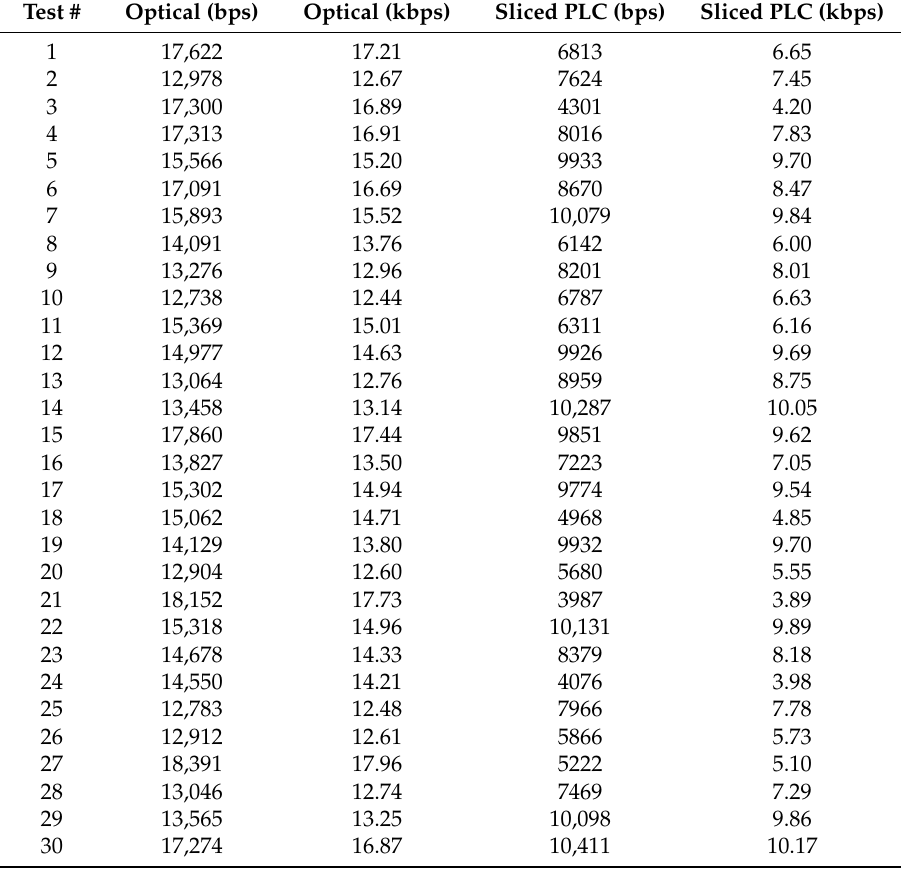
Table 5. Firmware upgrade throughput test results for 1MB files through both optical and sliced PRIME PLC